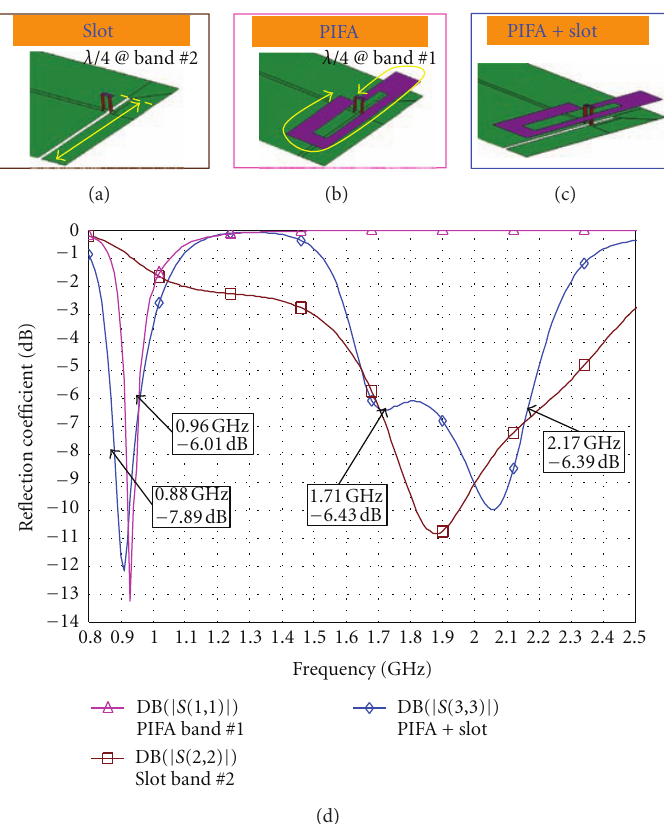
F 17: Sequence showing the antenna concept. (a) A slot on the ground plane is tuned at 1900GHz (band #2); (b) PIFA is tuned at 900MHz (band #1); (c) parallel e�citation of both antennas (PIFA � slot); (d) re�ection coe�cient of the antenna system. Ground plane is